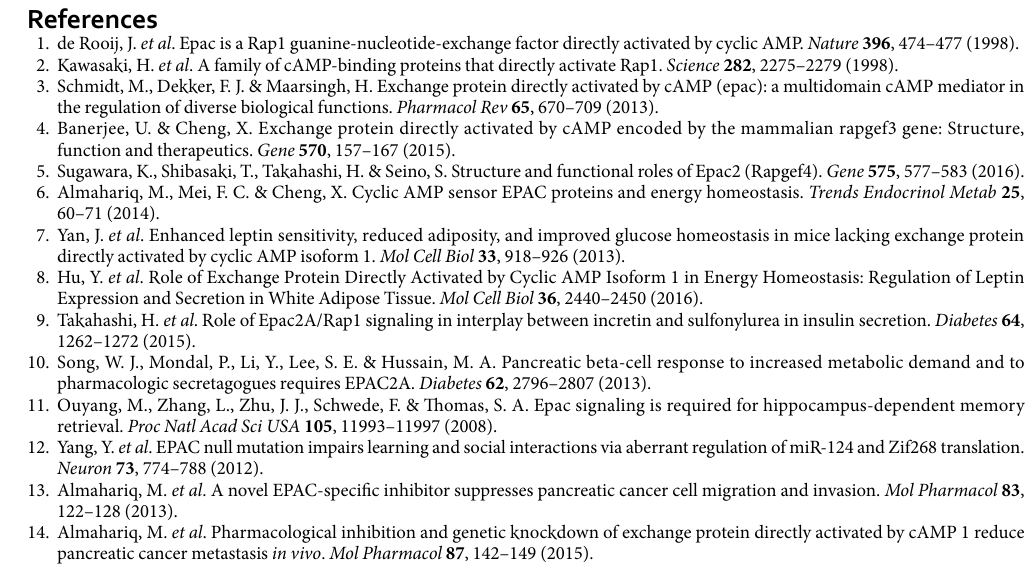
100 µ l ice-cold ELISA buffer (20 mM Tris-HCl, pH 7.4, 150 mM NaCl, 10 mM MgCl 2 and 0.1% Tween-20) for 3 times, 100 µ l mouse anti-Flag antibody (1:5000 in ELISA buffer) was added into each well and incubated at 4 °C for 1 hour with gentle shaking. Following three washes with 100 µ l ice-cold ELISA buffer, 100 µ l anti-mouse HRP-conjugated antibodies (1:3000 in ELISA buffer) were added into each well. After incubation at room tem- perature for 1 hour with gentle shaking, the wells were washed three times with 100 µ l ELISA buffer. 200 µ l of OPD substrate was added into each well and absorbance signal at 450 nm was monitored using an M2 microplate reader (Molecular Devices) for 30 min with 1-min intervals. 10-min data points were used for quantification. Data availability statement.